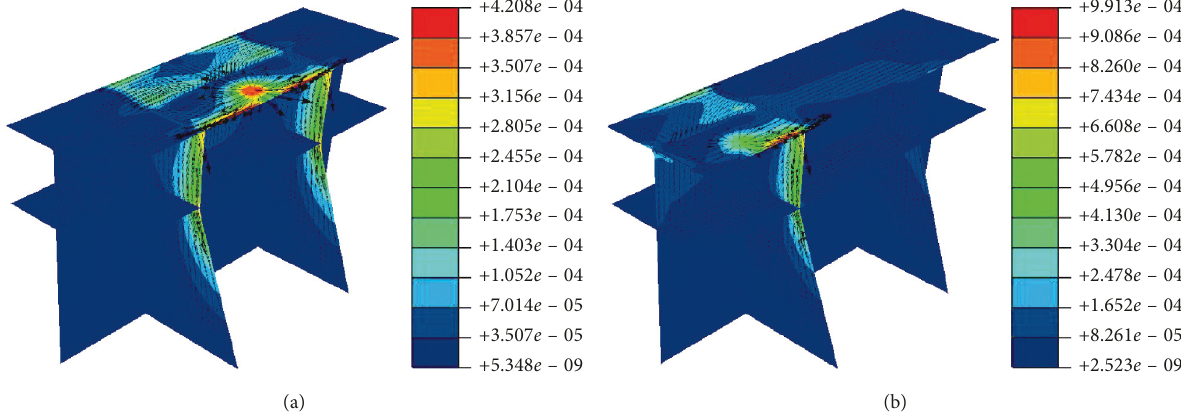
Figure 7: Power flow cloud and vector diagram of foundation at room temperature. The incentive is located at (a) point A and (b) point B (unit: